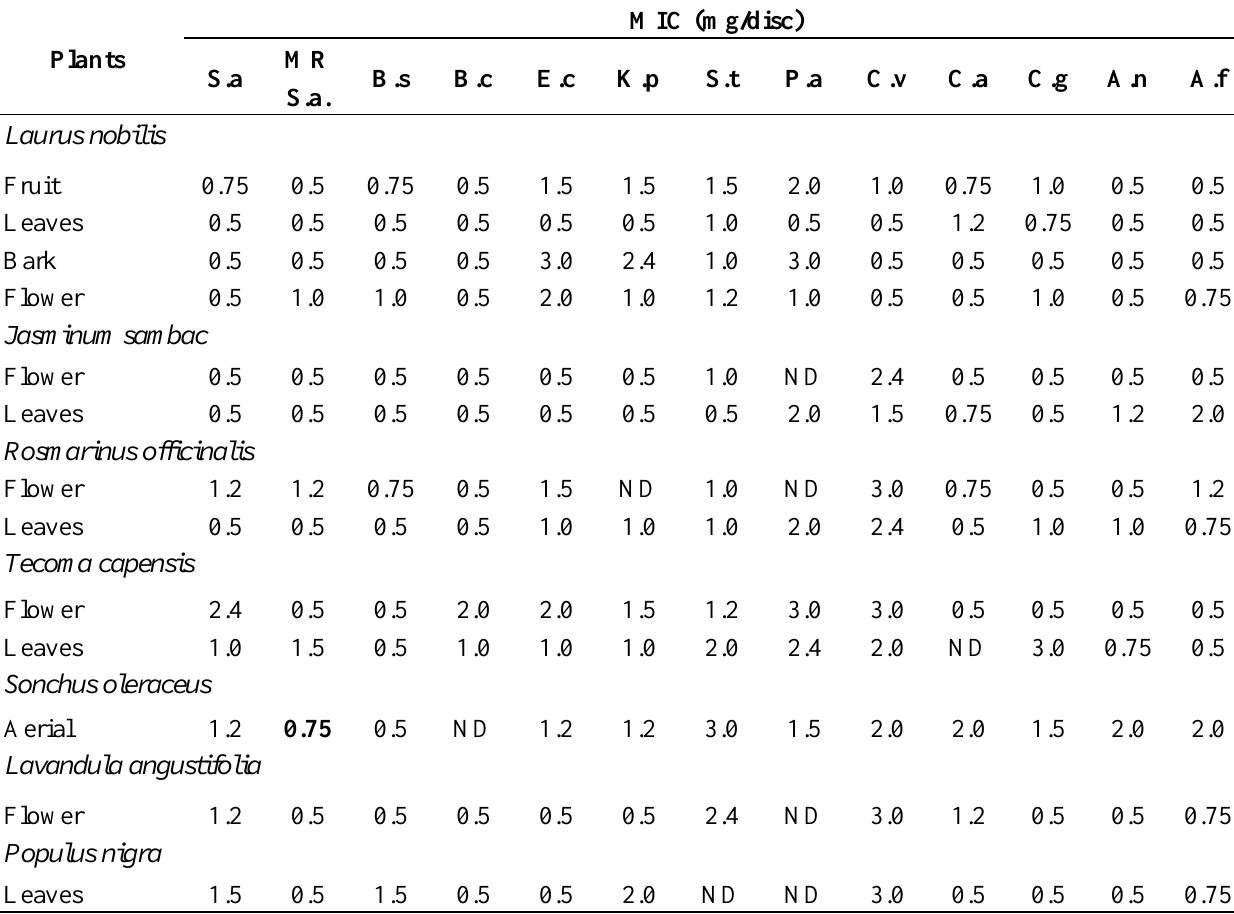
Table 4. Minimum inhibitory concentration (MIC) in mg/disc for different ethanol plants extracts.